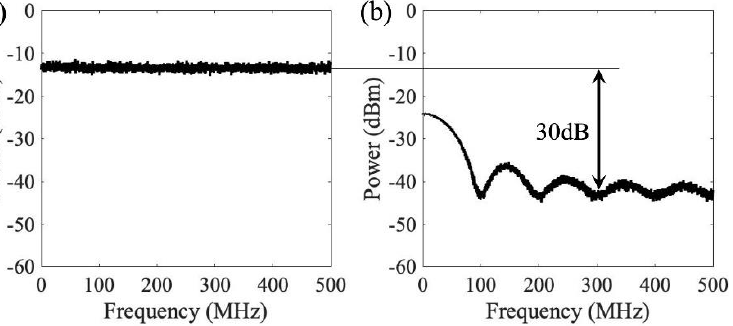
Figure 6. Base band spectrum of anti-jamming system ( a ) Received signals without removing the jamming signal ( b ) Recovered signal of interest after removing the jamming signal.